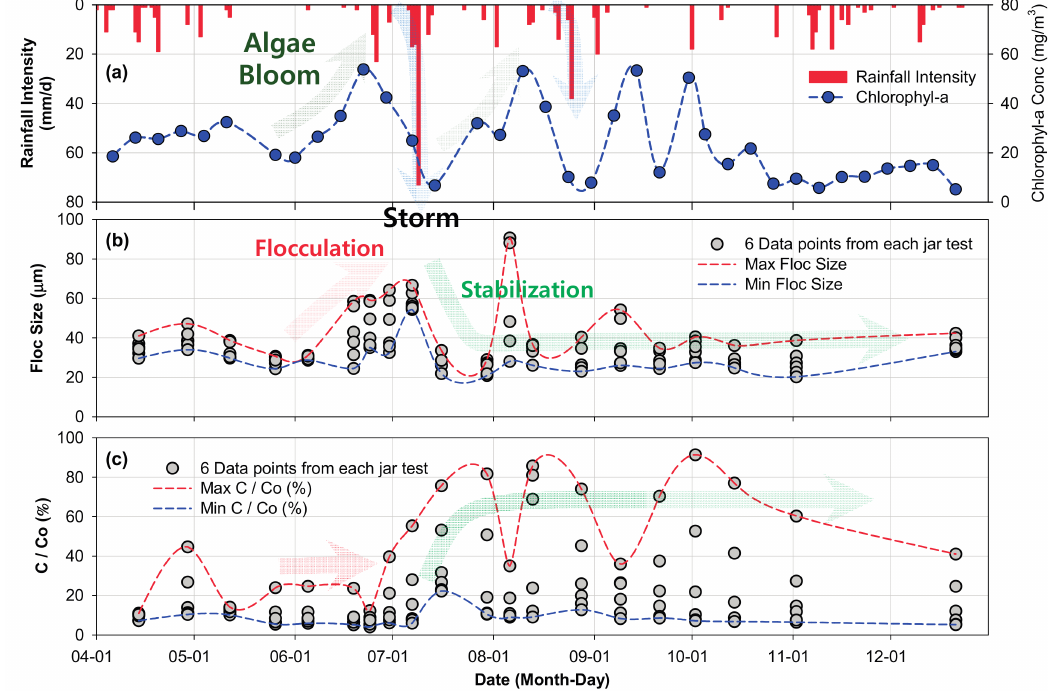
Figure 6. ( a ) Seasonal variation in the biochemical drivers and the flocculation potential via ( b ) floc diameter (D Floc ), and ( c ) the normalized ratio of the residual solid concentration (C/Co).